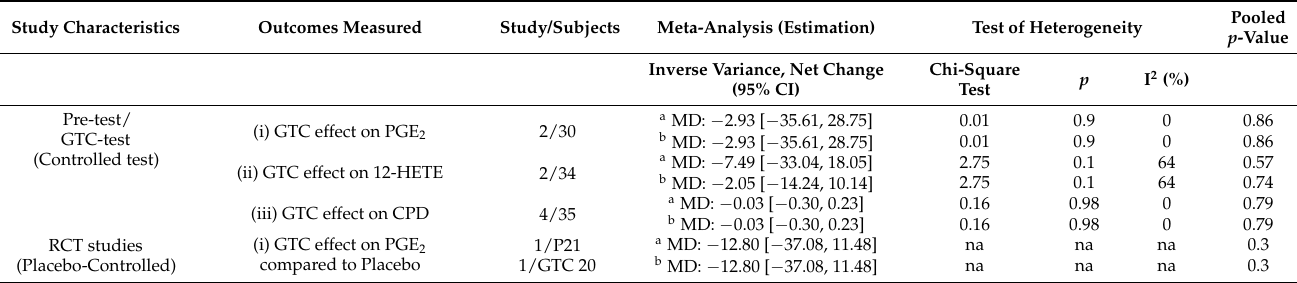
Table 4. Meta-analyses of ultraviolet radiation-induced pro-inflammatory mediator eicosanoids and pyrimidine dimers ranked by green tea catechin supplemented studies on healthy